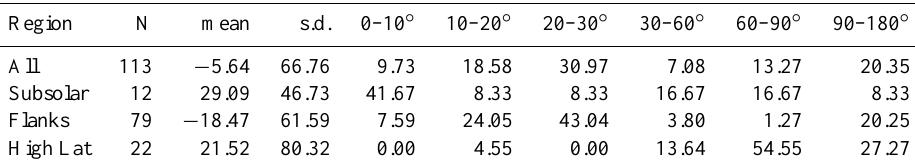
Table 14. Distribution of angular differences in the high pressure case (solar wind dynamic pressure > 2nPa) for Northward IMF (IMF clock angle between − 15 ◦ and 15 ◦ ). Format as in Table 3.